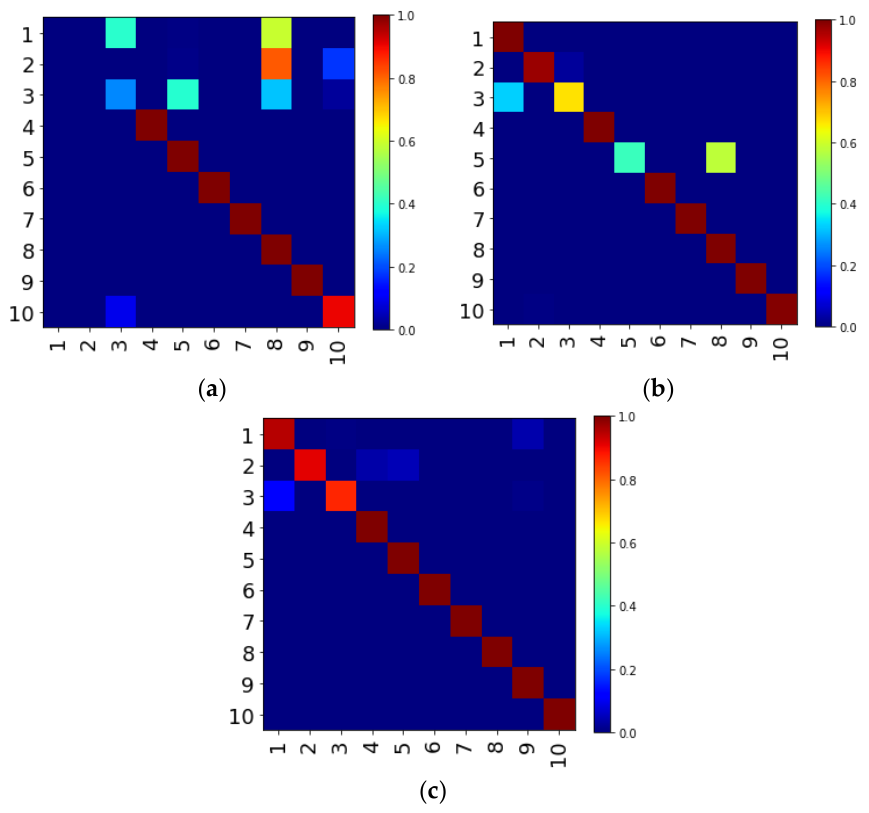
Figure 12. Information fusion between drive-end and fan-end predictions: ( a ) C-A fan end confusion matrix; ( b ) C-A drive end confusion matrix; ( c ) C-A confusion matrix after DS evidence fusion.